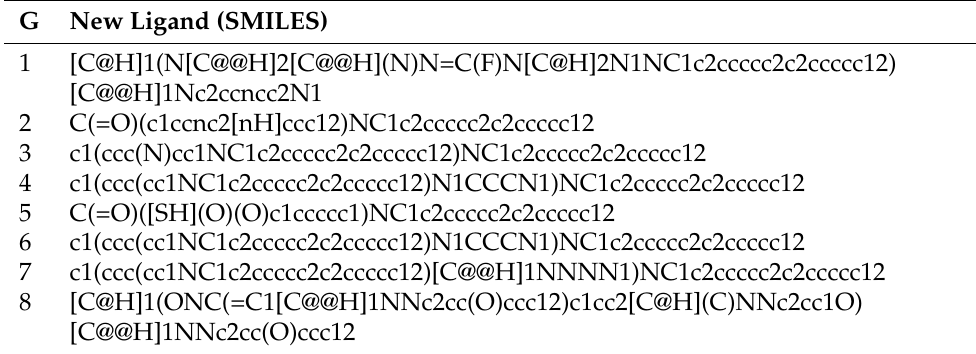
Table 6. New ligands with best binding energy using the semi-exhaustive approach. G New Ligand